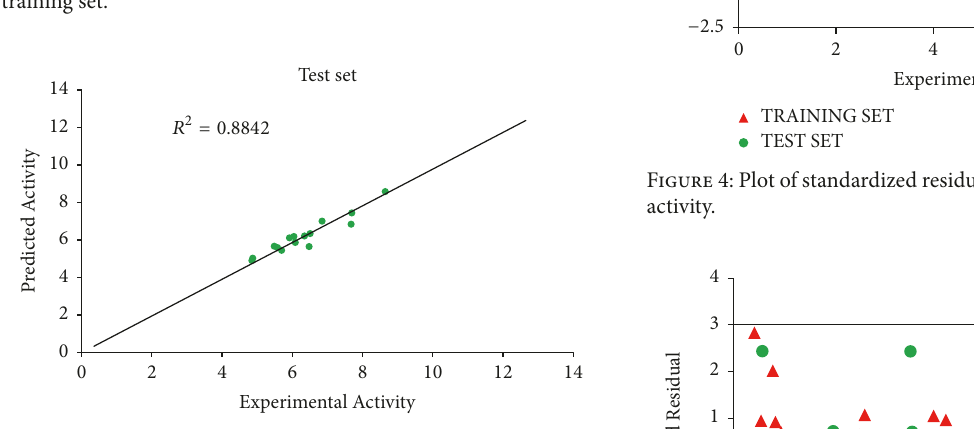
Figure 3: Plot of predicted activity against experimental activity of test set.